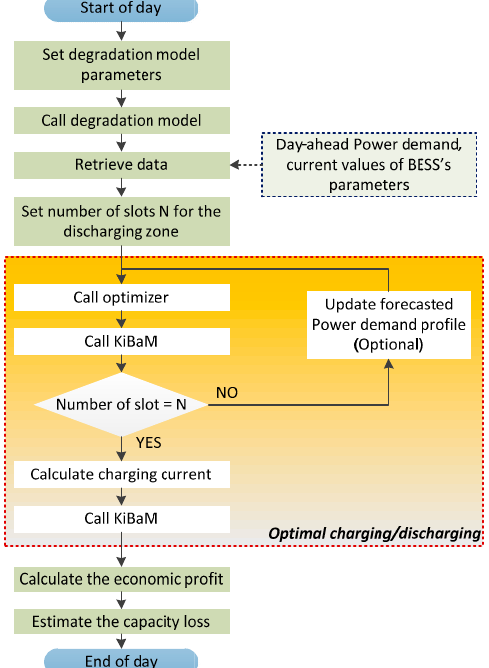
Figure 6. EMS at spring/summer ToU tariff.